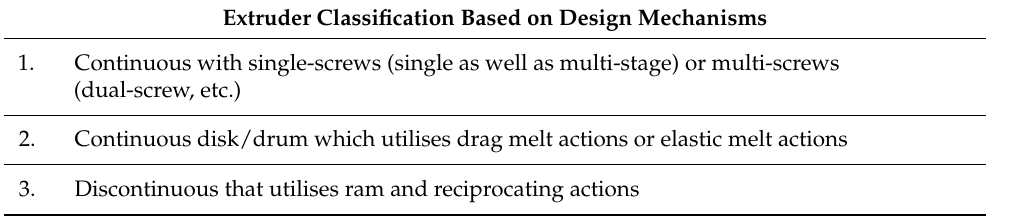
Table 2. Extruder types. Source [136].